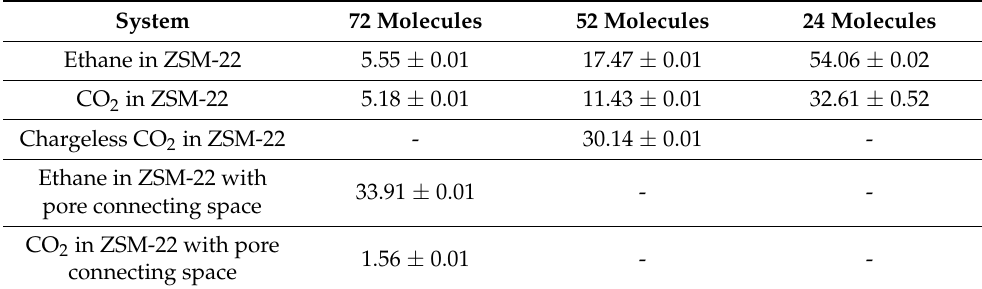
Figure 4. Mean squared displacement (MSD) as a function of time in ( a ) linear scale, and ( b ) log-log scale. Three distinct regions corresponding to ballistic, sub-diffusive, and diffusive motions can be identified in ( b ). nCO 2 refers to CO 2 with no electrostatic interactions used in the simulation. Table 3. Self-diffusion coefficients in the units of 10 − 10 m 2 /s obtained from the long-time behavior of MSD from different simulations.